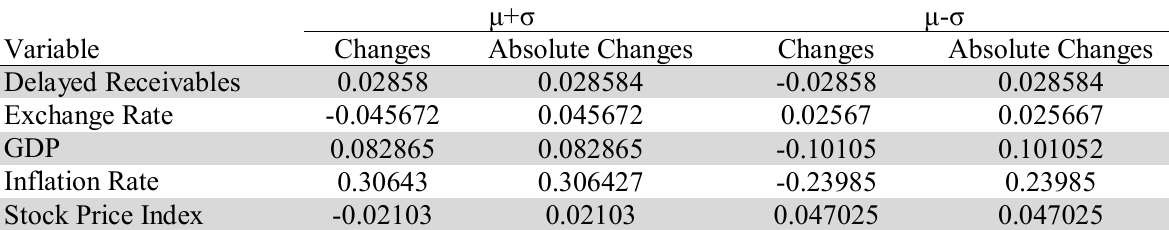
The summary of sensitivity